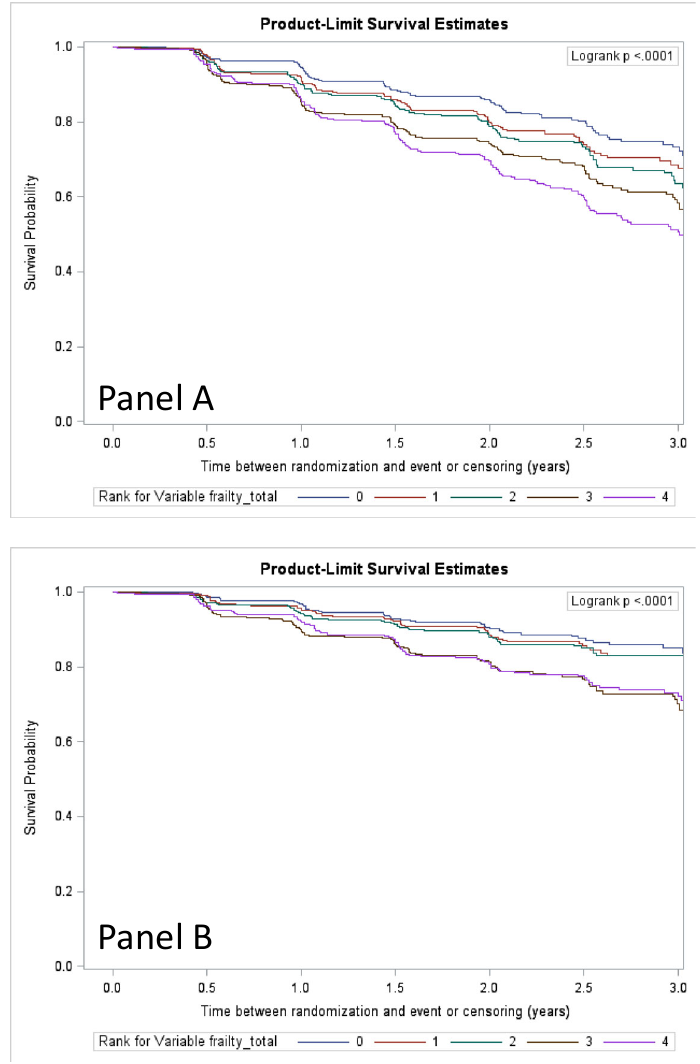
Figure 2. Kaplan-Meier plots of major mobility disability (MMD) (Panel A ) and persistent MMD (pMMD) (Panel B ) for quintile-stratified frailty index groups over 3 years of follow-up. Quintile 0 is equivalent to the group with the least frailty measures and Quintile 4 is the group with the most.